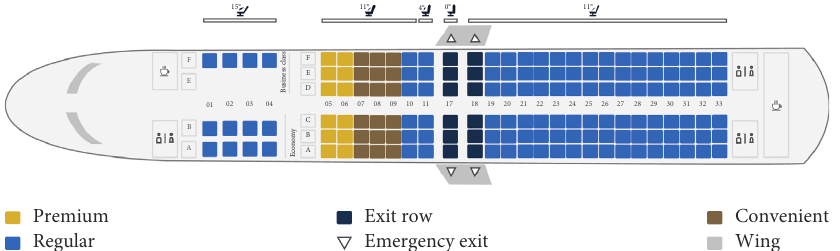
Figure 7: Seating configuration for an Airbus A320.